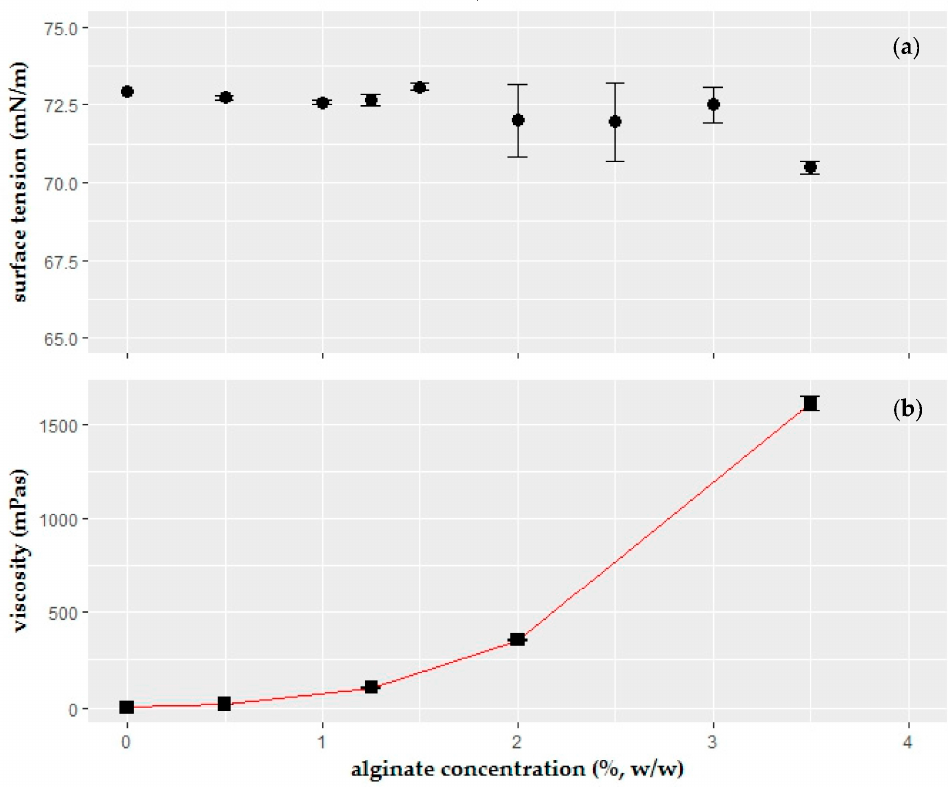
Figure 1. Effect of sodium alginate concentration (%, w / w ) on ( a ) surface tension (mN/m); ( b ) viscosity (mPa ∙ s) of the coating solution ( n = 3).